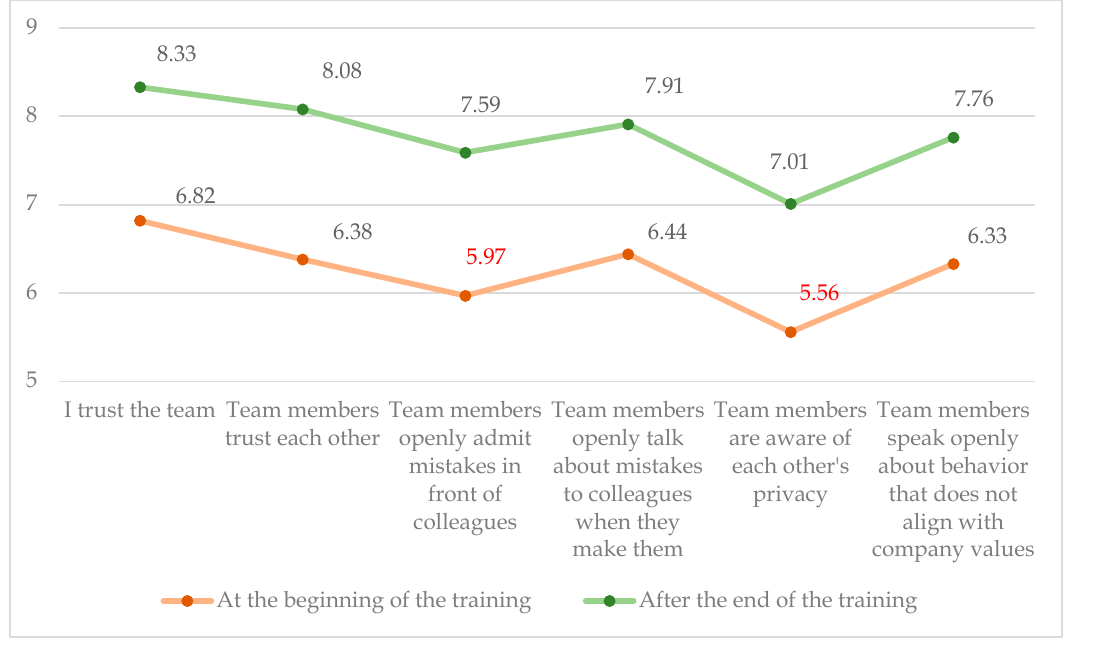
Figure 5. Results of answers to the block of questions “Providing and receiving feedback” (in com- parison of answers to questions at the beginning and after the end of the training).